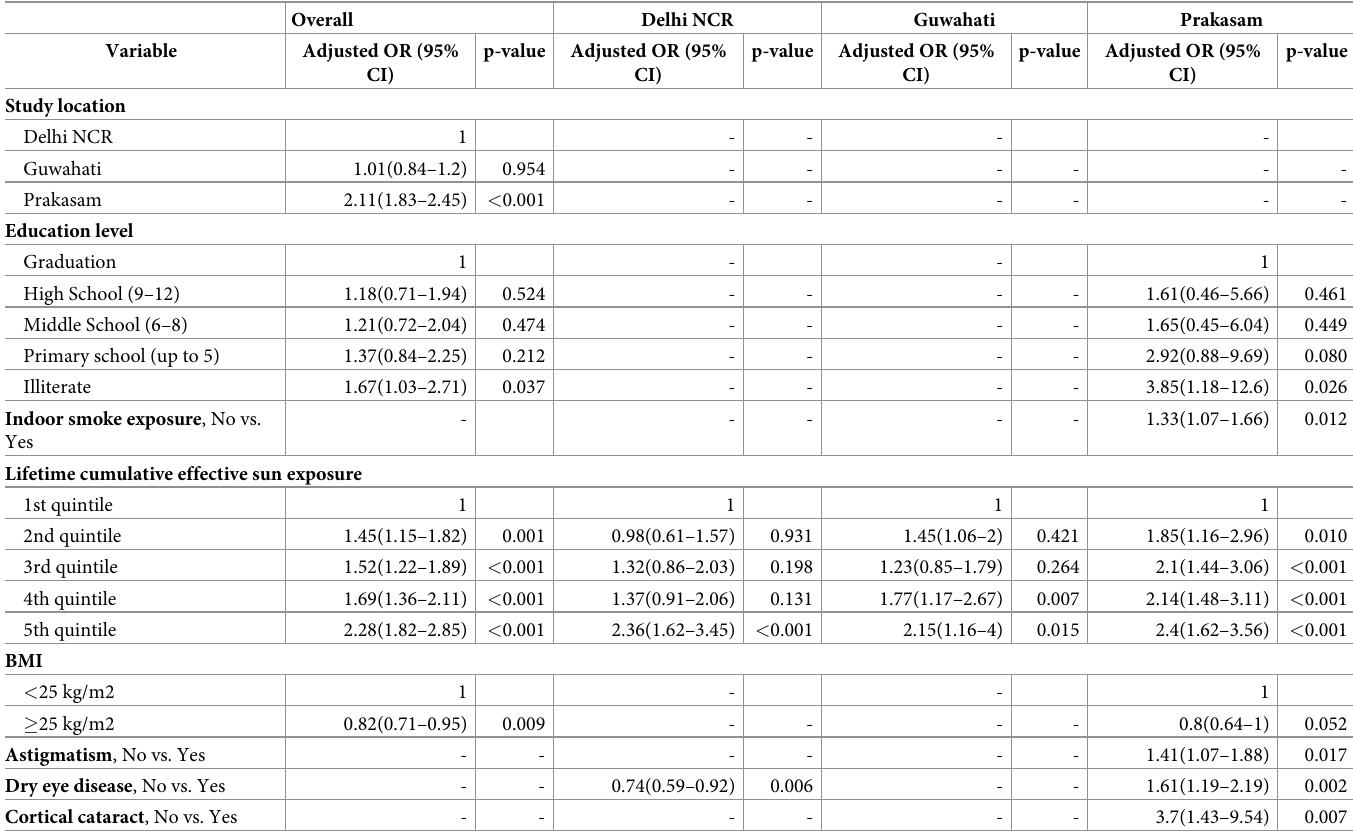
Table 4. Significant associations of pterygium on multivariate